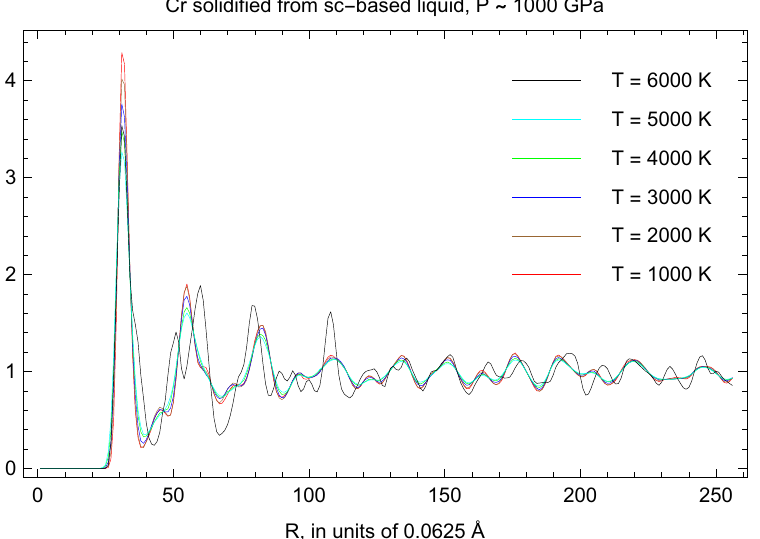
Figure 8. RDFs of the final states of the solidification of liquid Cr at ∼ 1000 GPa at lower